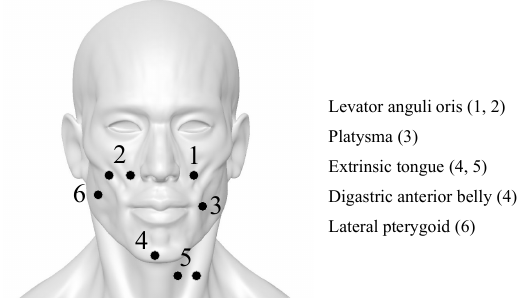
Figure 1. Recording sites around the face and neck. These dedicated positions form an articulator muscular net to decode the silent speech. The sites are cleaned by gel to ensure the impedance is lower than 5 k Ω between electrodes and skin surface.